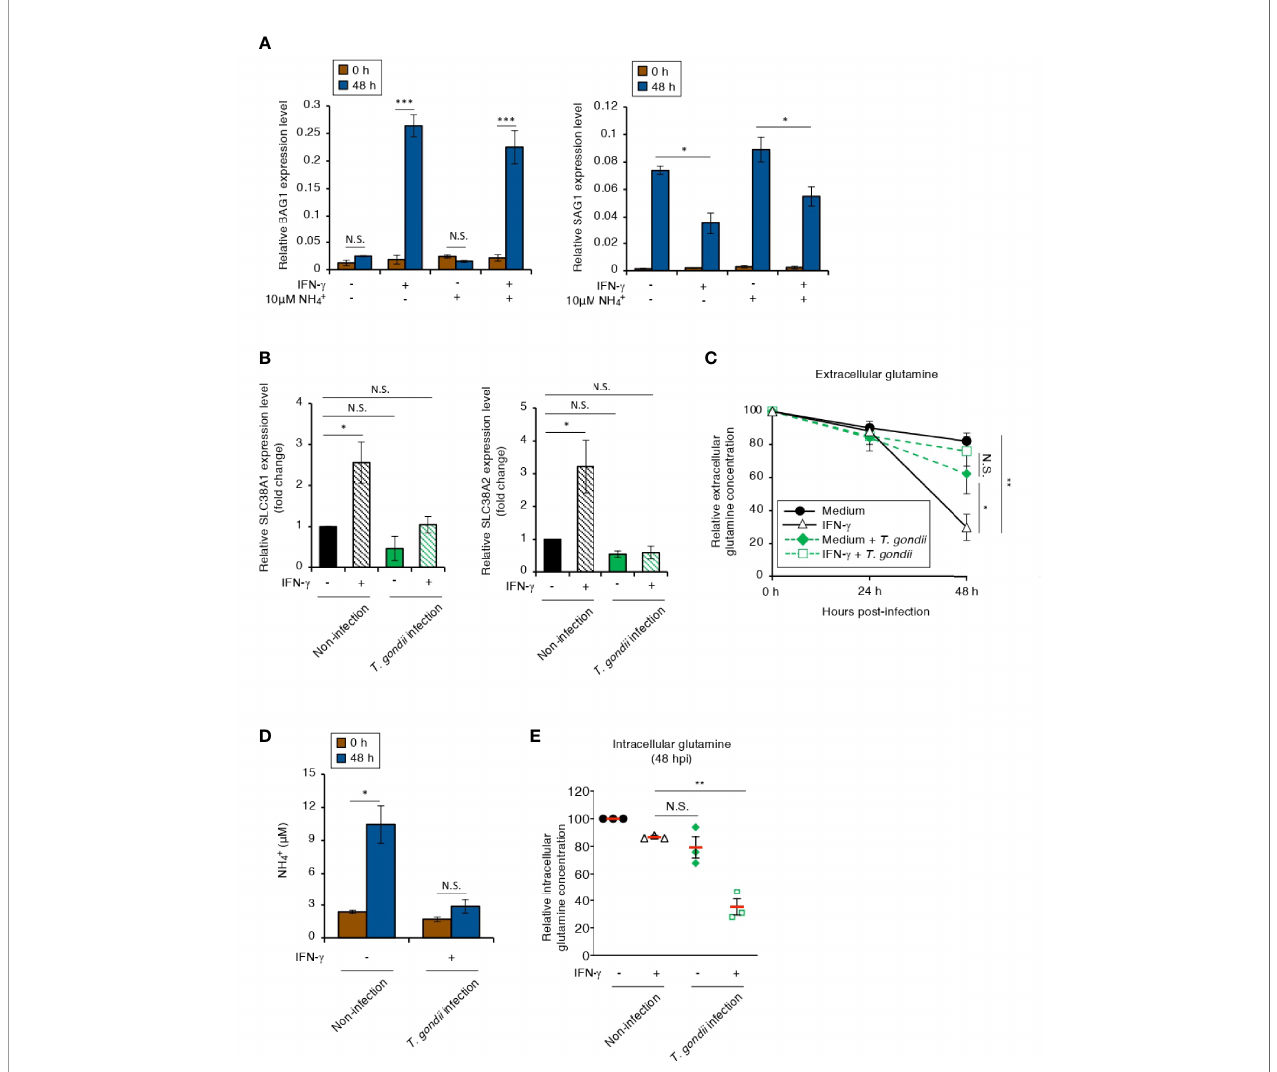
FIGURE 4 | The intracellular glutamine concentration decreases in an IFN- g -stimulated, T. gondii -infected human neuroblastoma cells. (A) IMR-32 cells infected with T. gondii ME49 were untreated or treated with IFN- g and/or NH + 4 and incubated for 0 or 48 h. The BAG1 or SAG1 mRNA level was analyzed by use of quantitative RT-PCR. (B) IMR-32 cells uninfected or infected with T. gondii ME49 were untreated or treated with IFN- g and incubated for 0 or 48 h. The SLC38A1 and SLC38A2 mRNA levels were analyzed by use of quantitative RT-PCR. (C) IMR-32 cells uninfected or infected with T. gondii ME49 were untreated or treated with IFN- g . The glutamine level in the culture supernatant at 0, 24, and 48 h after parasite infection was measured by ELISA. (D) IMR-32 cells uninfected or infected with T. gondii ME49 were untreated or treated with IFN- g and incubated for 0 or 48 h. The amount of NH + 4 released into the culture supernatant was measured by IC. (E) IMR-32 cells uninfected or infected with T. gondii ME49 were untreated or treated with IFN- g . The level of intracellular glutamine at 48 h after parasite infection was measured by ELISA. Values are means ± SD (three biological replicates per group from three independent experiments) (A – E) . * p < 0.05, ** p < 0.01, *** p < 0.001; N.S., not signi fi cant; Student ’ s